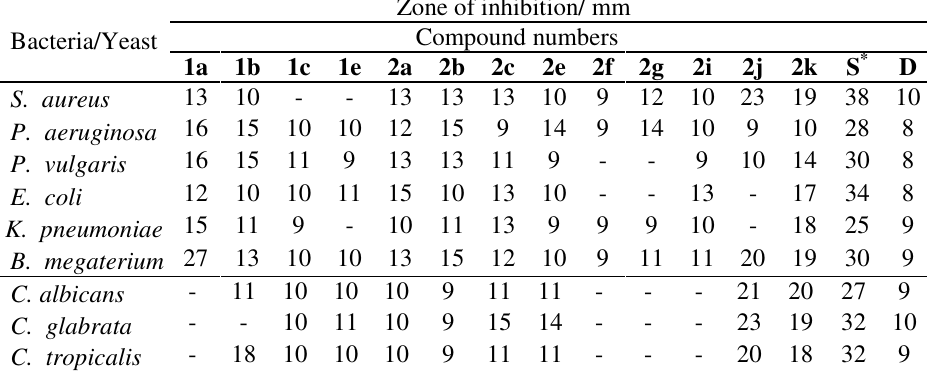
Table 1. Antimicrobial and antifungal studies of synthesized compounds Zone of inhibition/